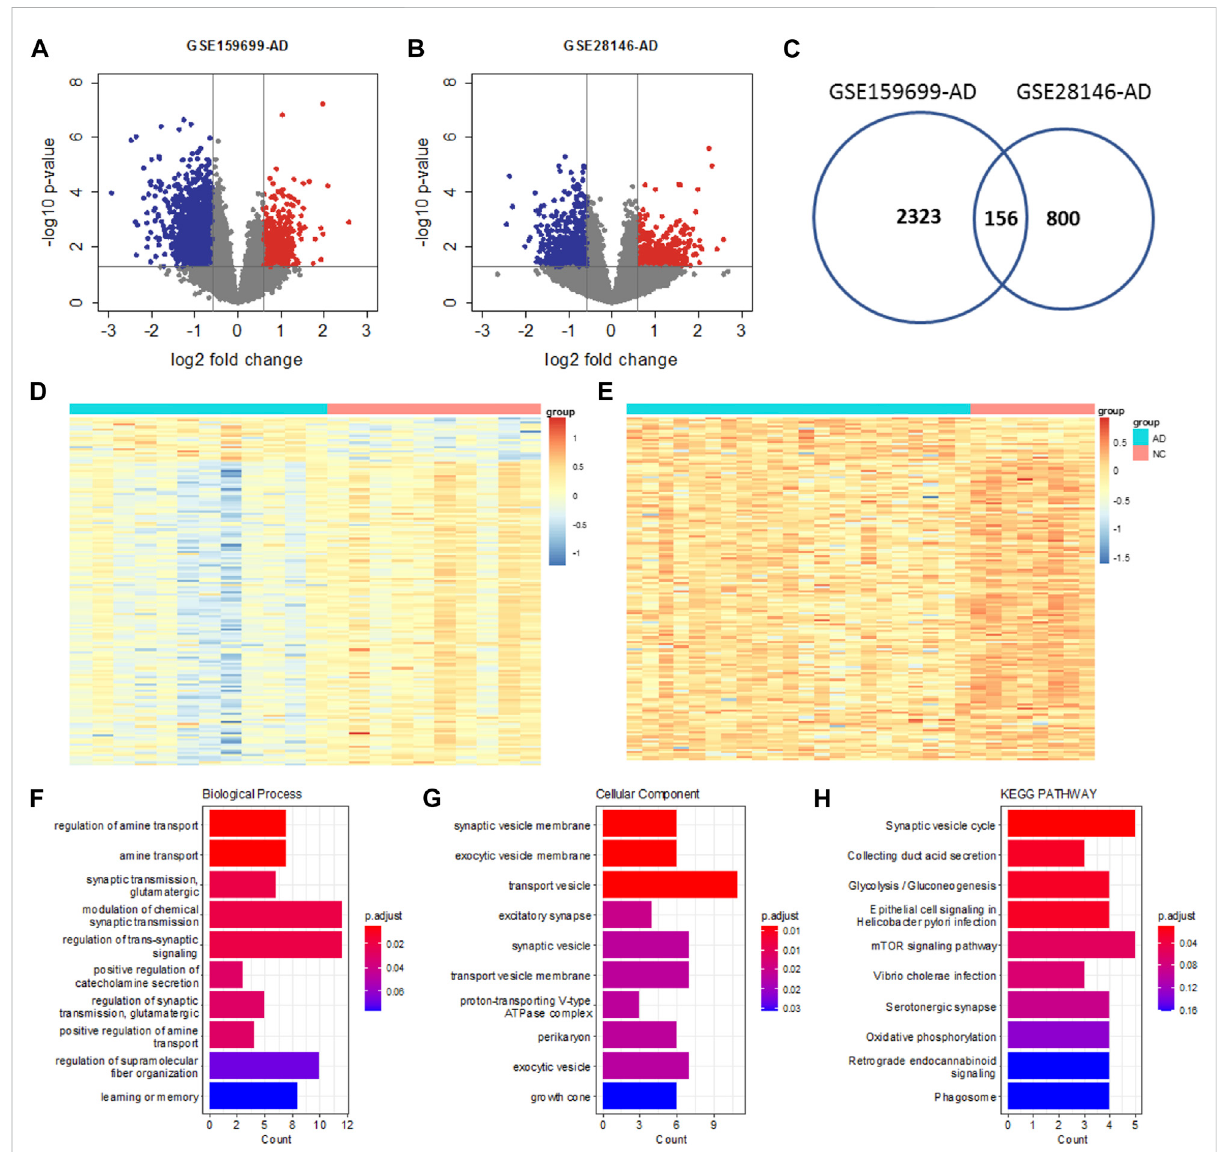
FIGURE 1 Differential analysis of AD. Volcano plot of GSE159699 (A) and GSE28146 (B) . DEGs are de fi ned as genes with |FC| > log 2 (1.5) and p -value < 0.05. (C) VenndiagramshowingtheintersectionbetweenDEGsofGSE159699andGSE28146. HeatmapofexpressionchangesforthecommonADDEGs in GSE159699 (D) and GSE28146 (E) . (F – H) Functional enrichment analysis of the common AD DEGs using Biological Process, Cellular Component and KEGG